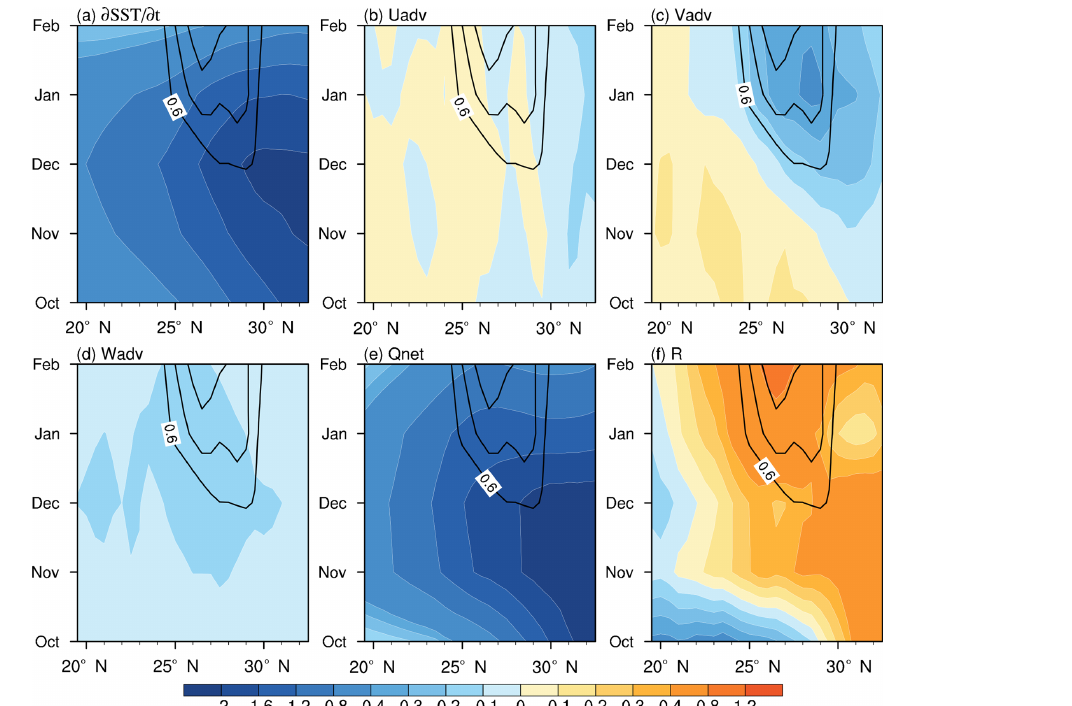
Figure 4. Latitude–time section of each term (shading; units: ◦ C month − 1 ) in Eq. (1) from October to the following February, averaged zon- ally over (140 ◦ E–170 ◦ W). (a) The total SST tendency ( ∂ SST /∂t ) and (b–f) the components on the right-hand side of Eq. (1), namely zonal temperature advection ( U adv ), meridional temperature advection ( V adv ), vertical temperature advection ( W adv ), the net heat flux ( Q net ) and the residual term ( R ). The black contours in each panel are the same, indicating the climatological monthly mean GM (units: ◦ C(100km) − 1 ) averaged zonally over 140 ◦ E–170 ◦